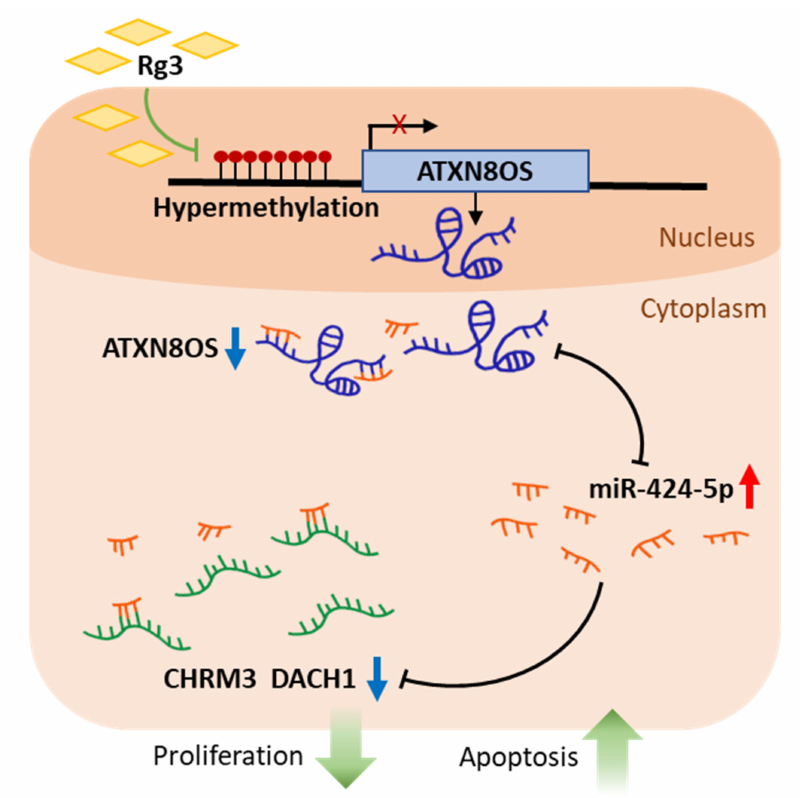
Figure 6. Schematic of the Rg3/ATXN8OS/miR-424-5p axis regulation process. ATXN8OS downreg- ulates the tumor-suppressive miR-424-5p, which in turn activates oncogenic CHRM3 and DACH1, leading to cancer-cell proliferation. Rg3 blocks the oncogenic activity of ATXN8OS by inducing promoter